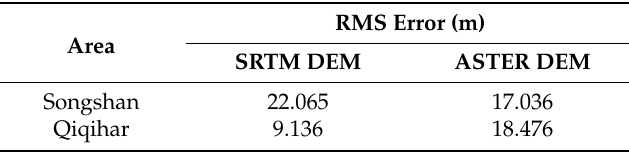
Table 3. The accuracy of Shuttle Radar Topography Mission (SRTM) DEM and Advanced Spaceborne Thermal Emission and Reflection Radiometer (ASTER)